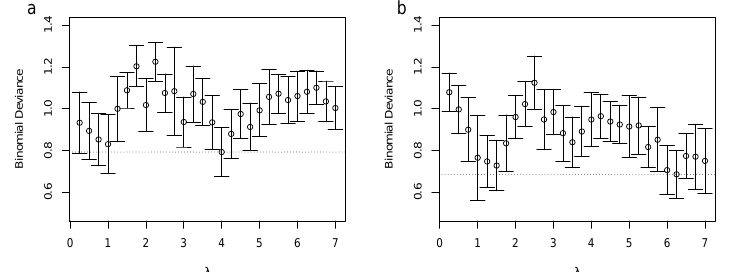
Figure 5. The binomial deviances ( y -axis) from the leave-one-out cross-validation using BF with regularization parameter ( λ ) values between 0.25 and 7.0 ( x -axis) for the plasma ( a ) and urinary ( b ) AKI data. The dotted horizontal line corresponds to the lowest observed binomial deviance across all λ values. The error bars correspond to ± 1 standard